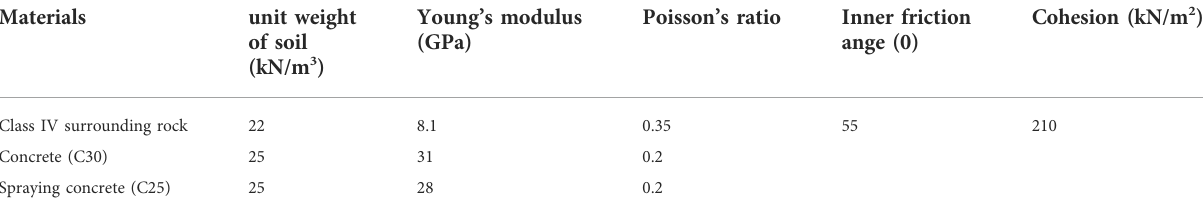
TABLE 1 Physical and mechanical parameters of materials.